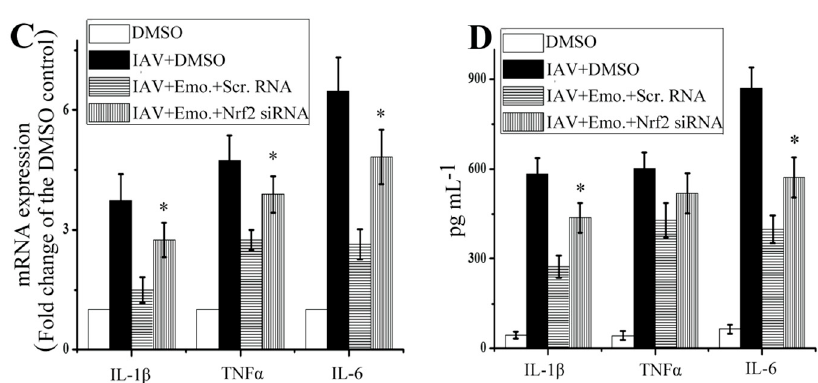
Figure 5. Effect of Nrf2 signaling on the inhibitory effects of emodin on IAV-induced inflammation and IAV replication. ( A , B ) Suppression of Nrf2 via siRNA blocked the inhibition of emodin on IAV-induced activations of TLR4, p38/JNK MAPK and NF- κ B and production of IAV M2 protein; ( C , D ) Suppression of Nrf2 via siRNA blocked the inhibition of emodin on IAV-induced up-regulation of inflammatory cytokines. DMSO (0.5%, v / v ), ribavirin (25 μ g mL − 1 ) or emodin (25 μ g mL − 1 ) were beforehand mixed with IAV (MOI = 0.001) and added to A549 cells for 24 h. Among them, two groups were pre-transfected with scramble siRNA and Nrf2-specific siRNA for 24 h, respectively. The protein levels were determined by western blotting, the production of inflammatory cytokines was determined by qRT-PCR and ELISA assays. Data were mean ± SD of five independent experiments, n = 5. * p < 0.05 vs. the scramble (Scr.) siRNA + IAV + emodin (Emo.) control.